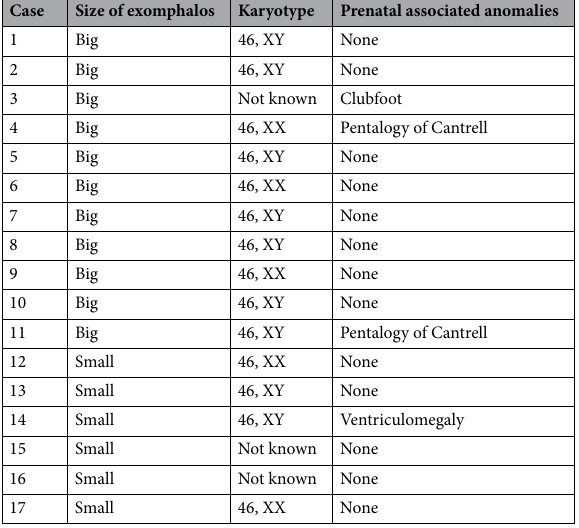
Table 2. The associated anomalies and karyotype aberrations of 17 fetuses with post-natal